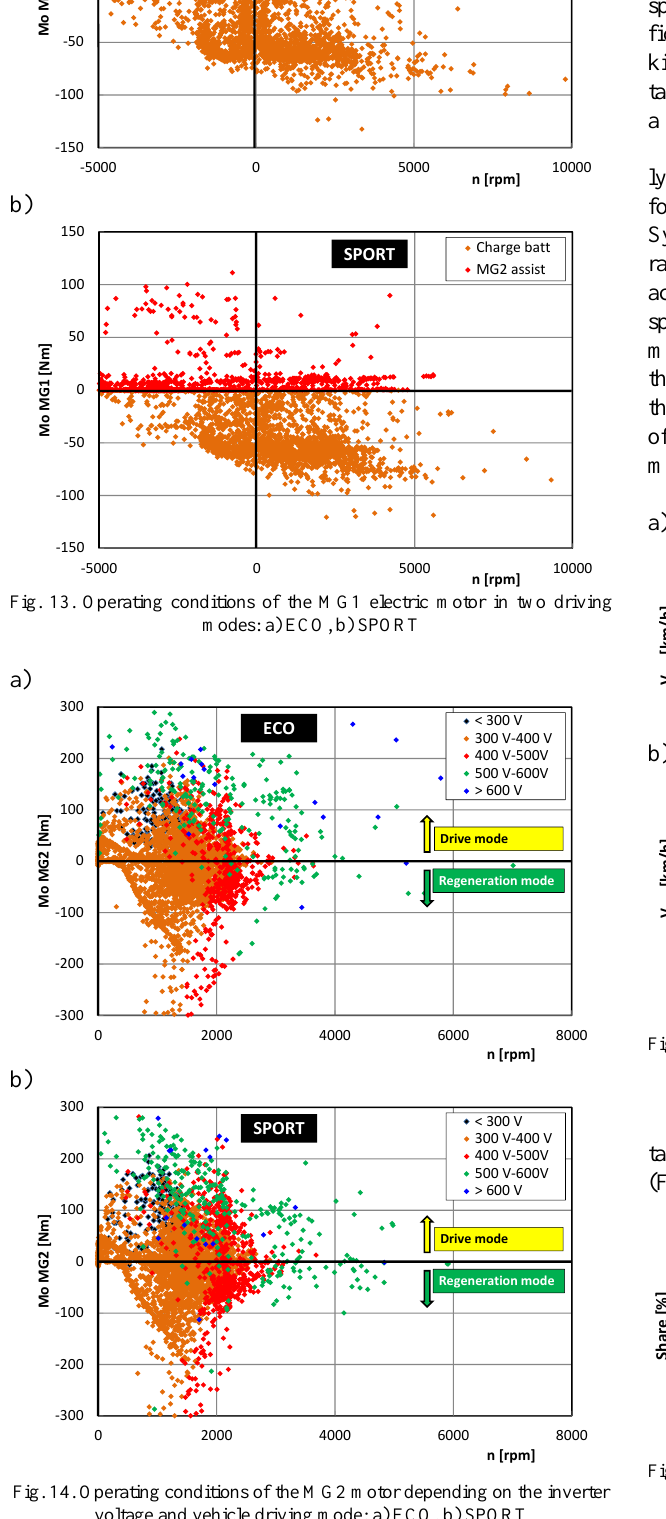
Fig. 14. Operating conditions of the MG2 motor depending on the inverter voltage and vehicle driving mode: a) ECO, b) SPORT